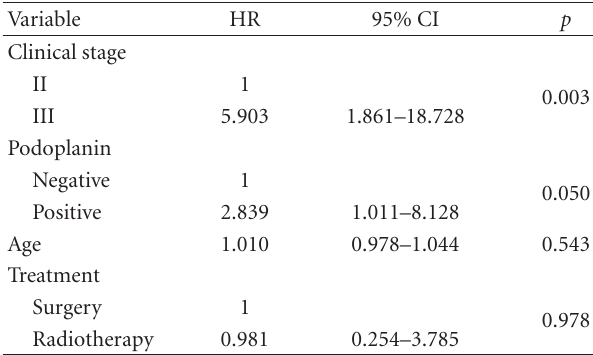
Table 5: Multivariate Cox regression model for specific cancer survival in patients with locally advanced cutaneous squamous cell carcinoma of trunk and